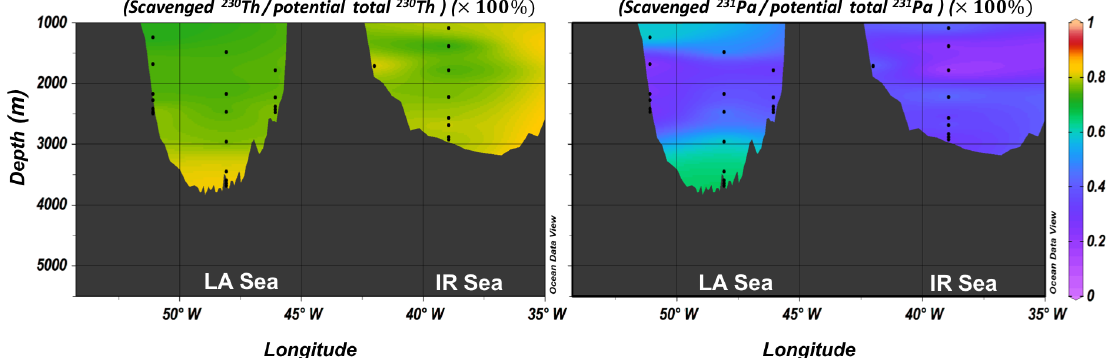
Figure 10. Ratio of scavenged component to potential total components for 230 Th and 231 Pa, providing an assessment of the relative importance of scavenging for the two nuclides and of the location of